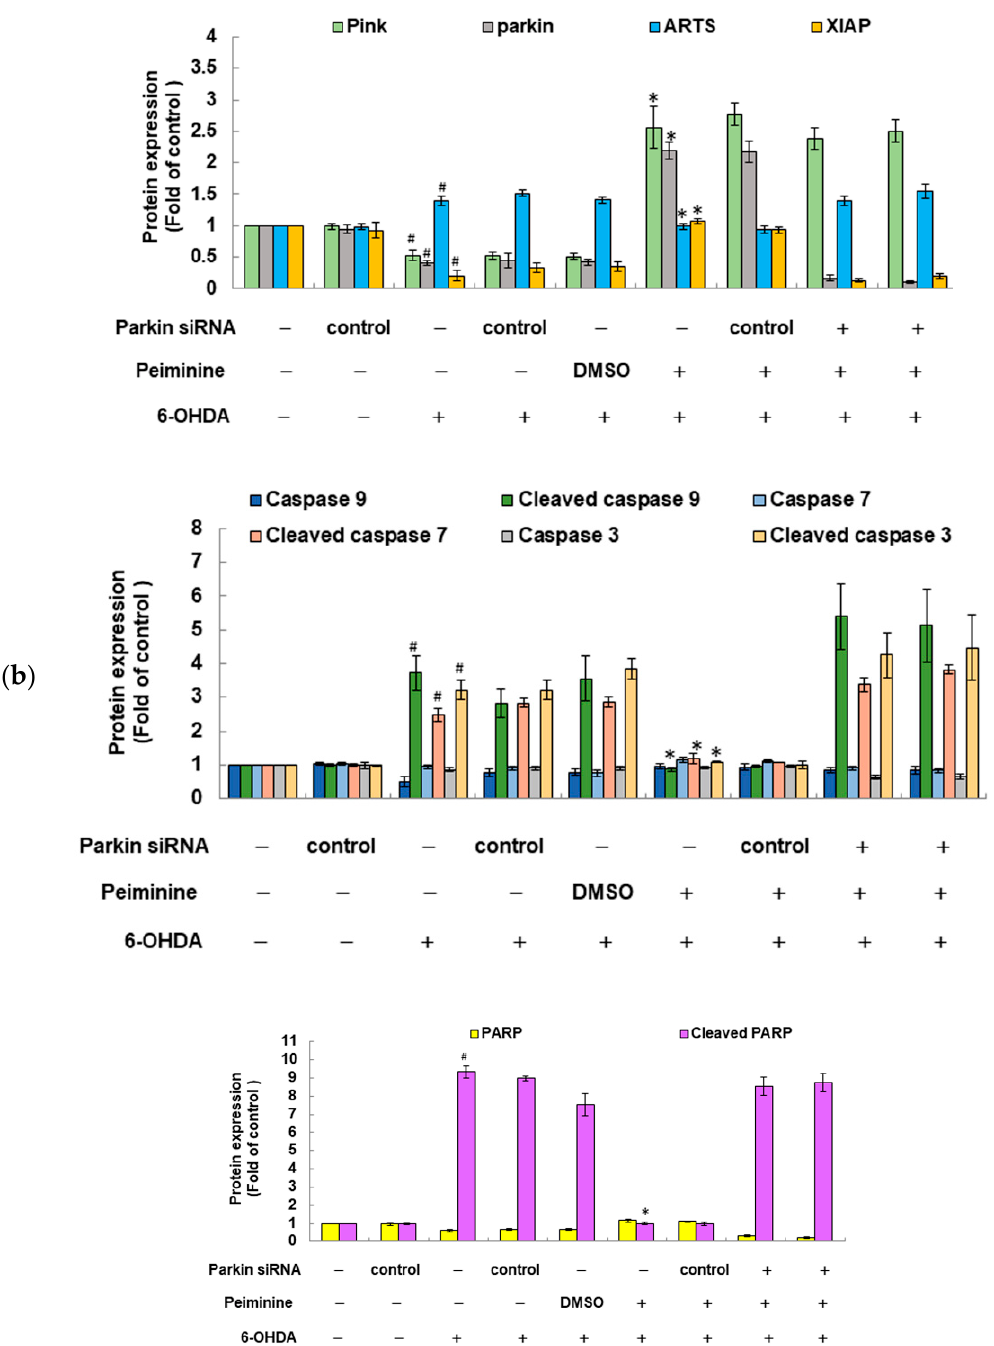
Figure 10. Western blot analysis was used to quantify the levels of PINK1, parkin, ARTS, XIAP, and apoptotic core proteins. SH-SY5Y cells were transfected with control siRNA or parkin siRNA for 24 h, and then the transfected cells were treated with 1 µM PMN or no treatment, respectively. After 24 h, cells were exposed to 100 µM 6-OHDA for 12 h. ( a ) Shows representative results from one of three independent experiments. ( b ) ImageJ software was utilized to quantify the signal intensity of the image in ( a ). The loaded internal control is the level of β -tubulin. The relative ratio is represented as the ratio of each group to the control group. # Indicates a significant difference between the 6-OHDA-exposed group and the control group ( # p < 0.001). * Indicates a significant difference between the PMN-pretreated 6-OHDA-exposed group and PMN-untreated 6-OHDA-exposed group (* p < 0.001).